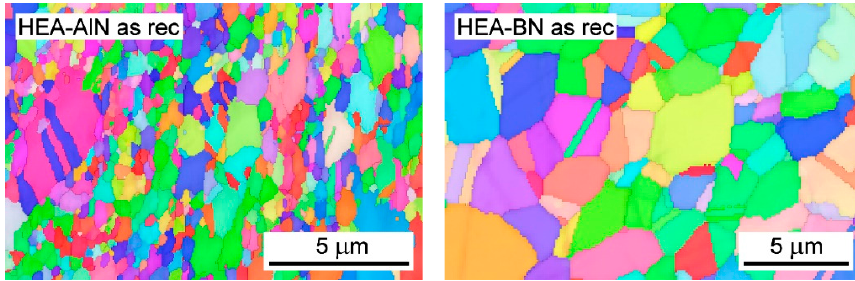
Figure 1. Microstructure of HEA-AlN ( left ) and HEA-BN ( right ) in the as-sintered state.